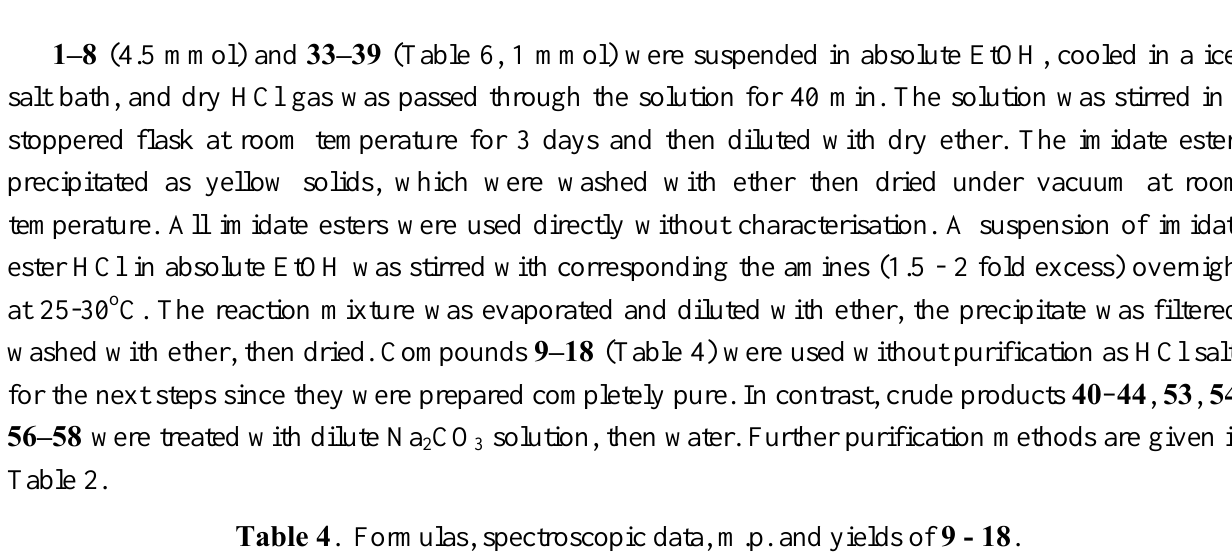
Table 4 . Formulas, spectroscopic data, m.p. and yields of 9 - 18